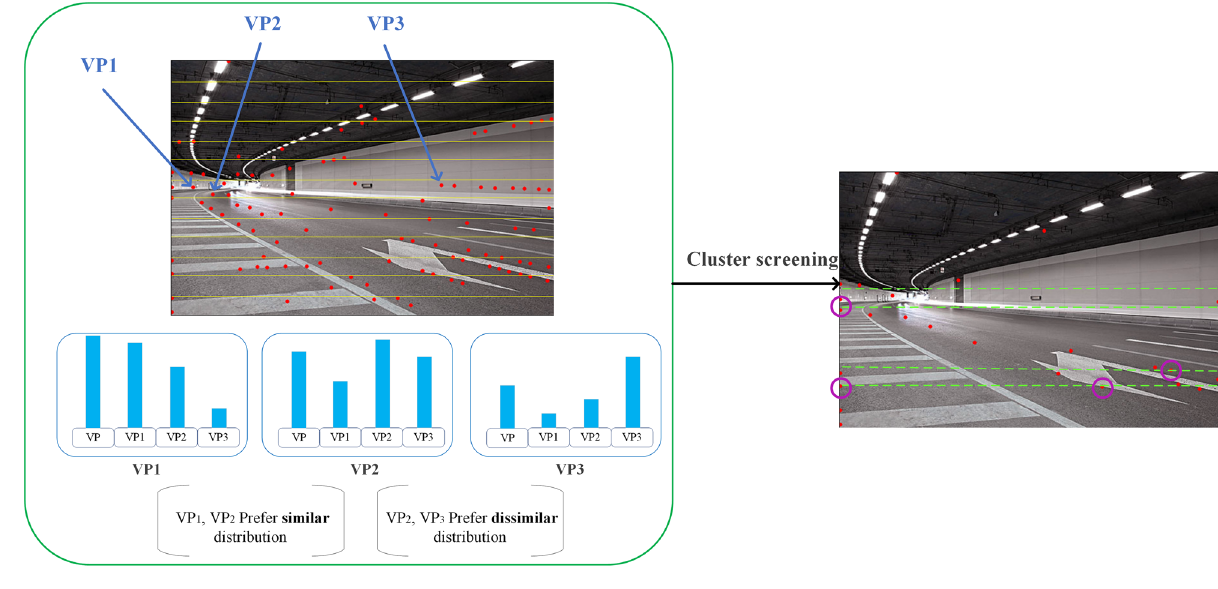
Figure 4. Clustering in row space.